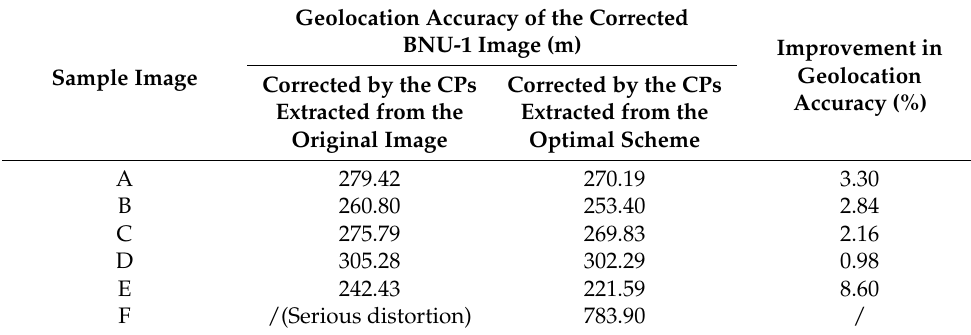
Table 3. Comparison of the geolocation accuracy of the BNU-1 images corrected through different CPs extraction